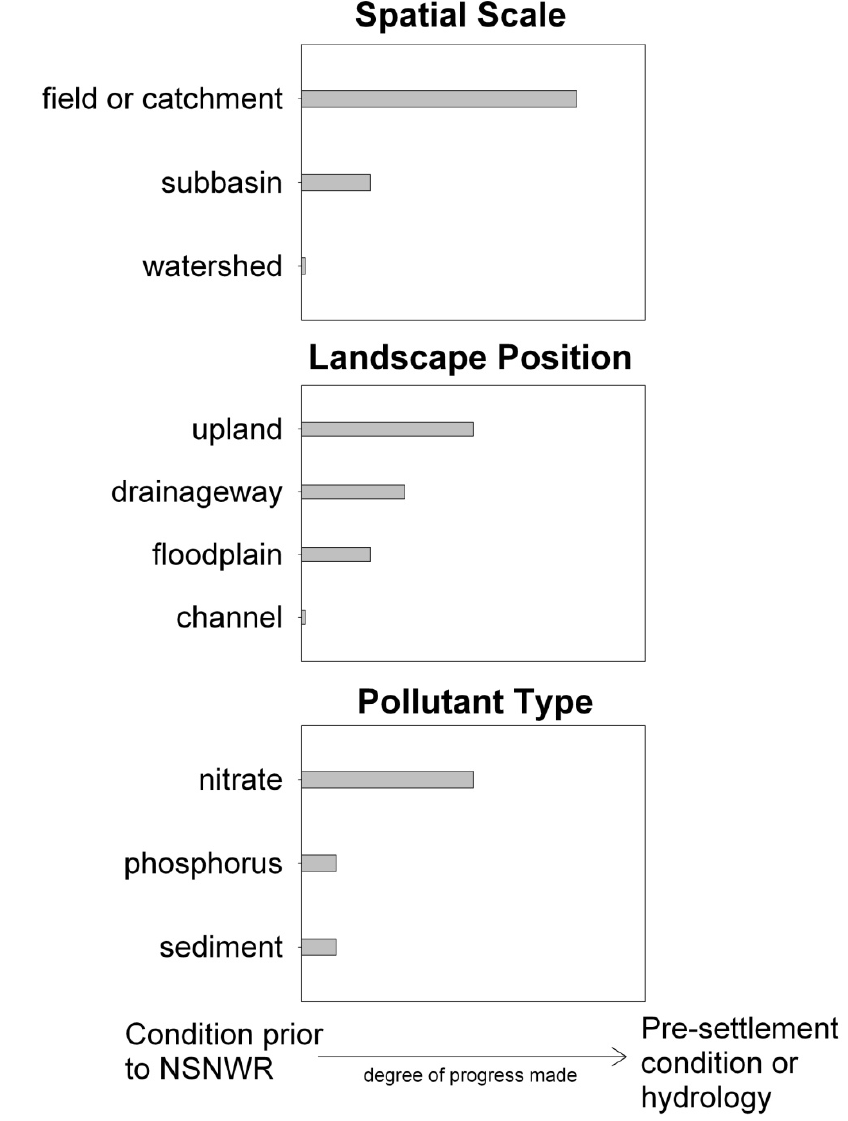
Figure 8. Summary of progress being made toward restoring hydrology to pre-settlement conditions specifically related to three key attributes. At what scale is progress being made (top panel), where on the landscape are changes being seen (middle panel), and what pollutant type is responding more readily to hydrologic improvements (lower panel). The degree of progress attempts to be independent of other